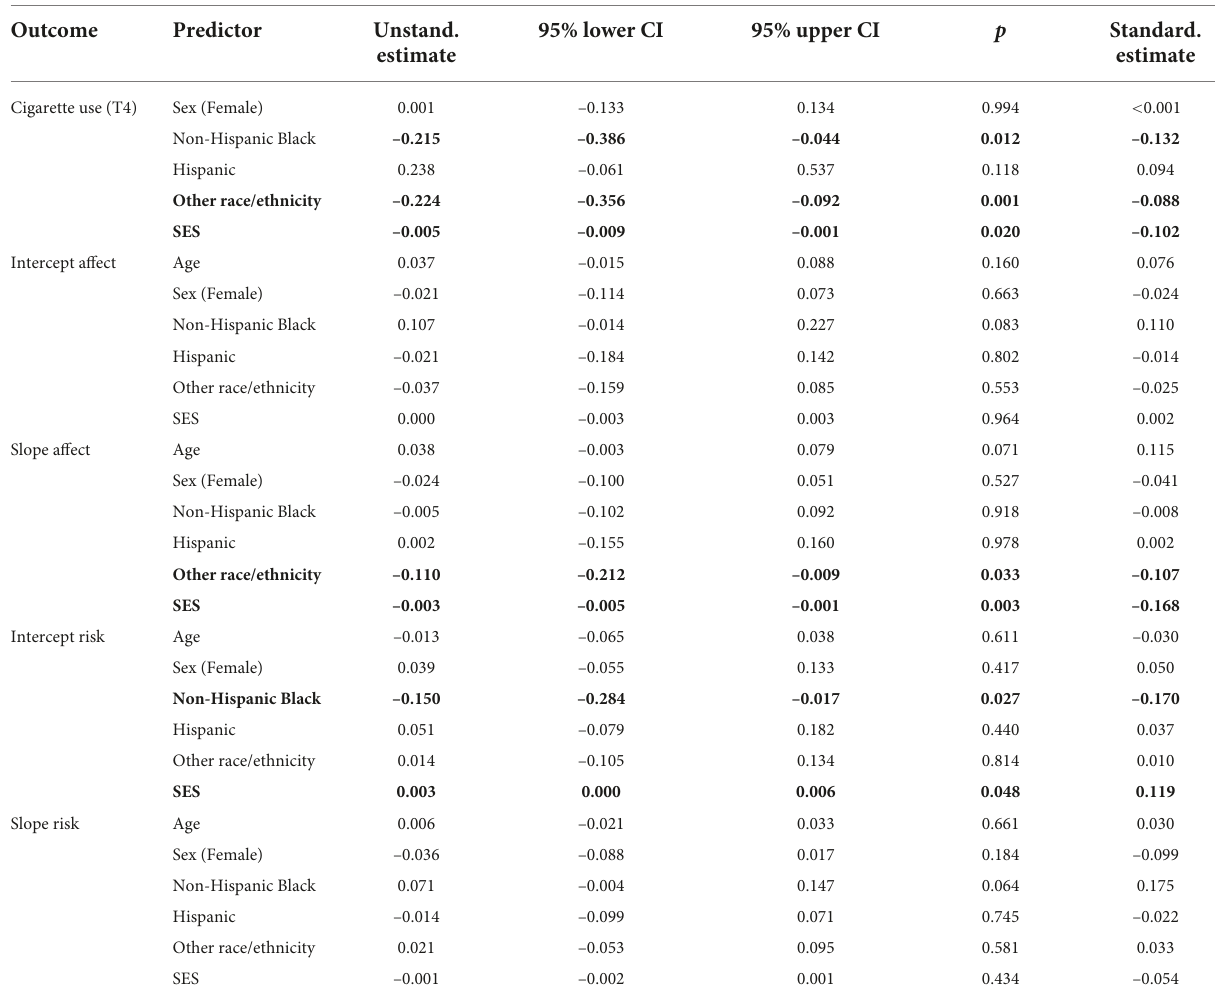
Table A1 Demographic parameter estimates from full